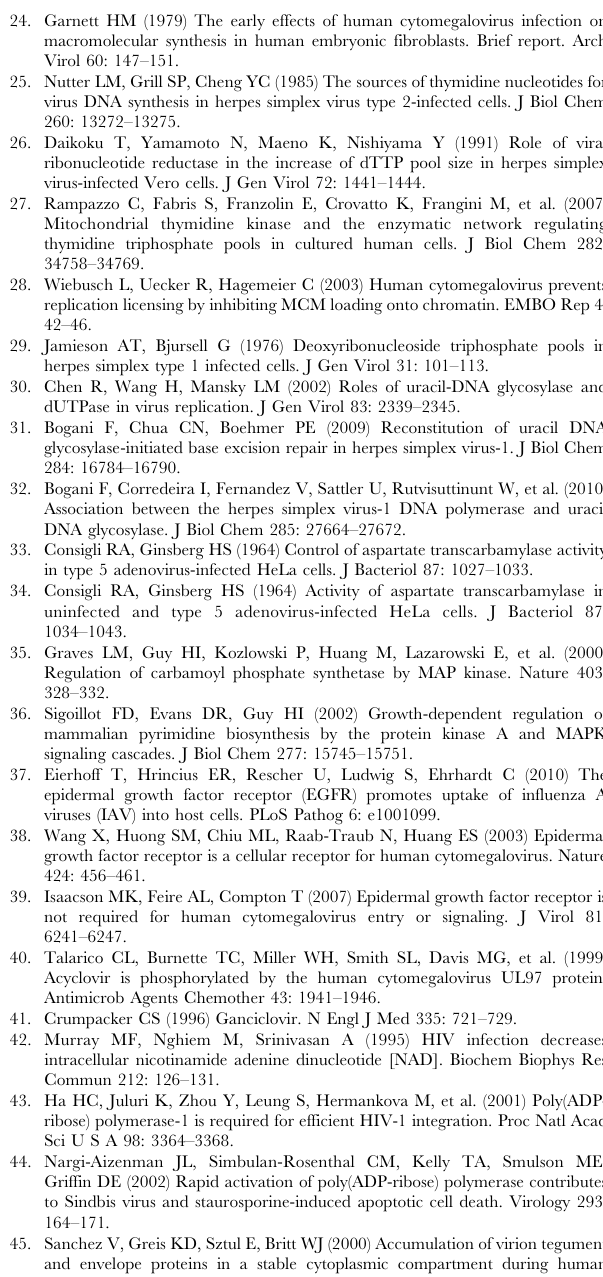
24 hpi in the presence or absence of TOFA. Trypan blue stain was added to an aliquot of cells to assess live/dead ratio. For each condition at least 500 cells were counted. Table S1 Metabolite levels during the course of HCMV and HSV-1 infection. Values are normalized by packed cell volume and expressed relative to levels measured in the equivalent mock treated host cells. Rows correspond to metabolites measured either by LC-high resolution MS or LC-triple quadrupole MS/ MS (those measured by triple quadruople are marked ‘‘QQQ’’). Columns correspond to hours post infection for each of the eight infection time courses. The host cells and virus strains used in each